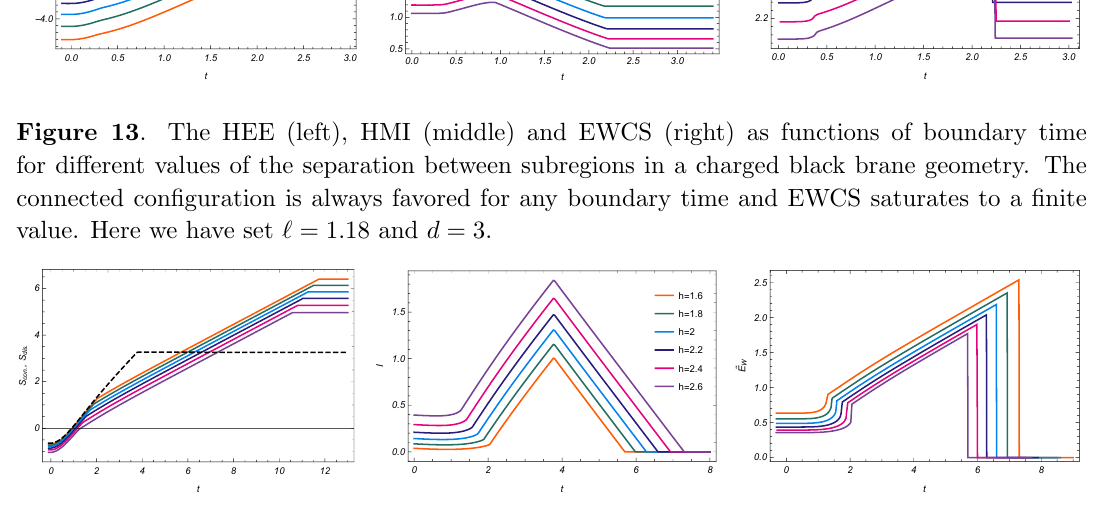
Figure 14 . The HEE (left), HMI (middle) and EWCS (right) as functions of boundary time for di(cid:11)erent values of the separation between subregions in a charged black brane geometry. At late times, the disconnected con(cid:12)guration is favored and EWCS saturates to zero. Here we have set ‘ = 4 : 5 and d =